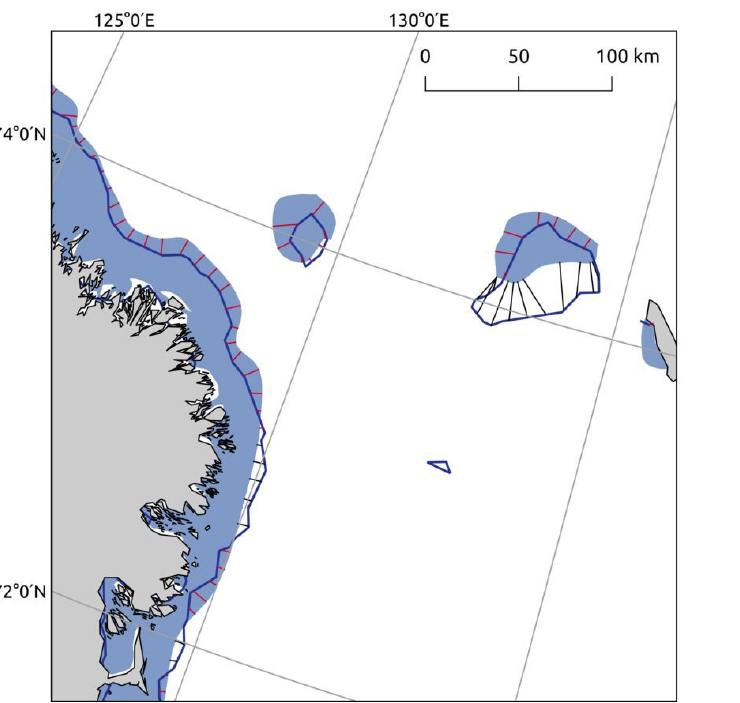
Figure 4. The fast ice conditions near the Lena Delta for 06 December 2007. The dark blue line shows the fast ice detected by the proposed algorithm. The light blue corresponds to the fast ice from AARI map issued on 5 December 2007. For the cross-comparison, distances between the fast ice edges were measured along the black/red lines (automatically drawn Euclidean distances). The red lines correspond to the negative distances, while the black lines—to the positive